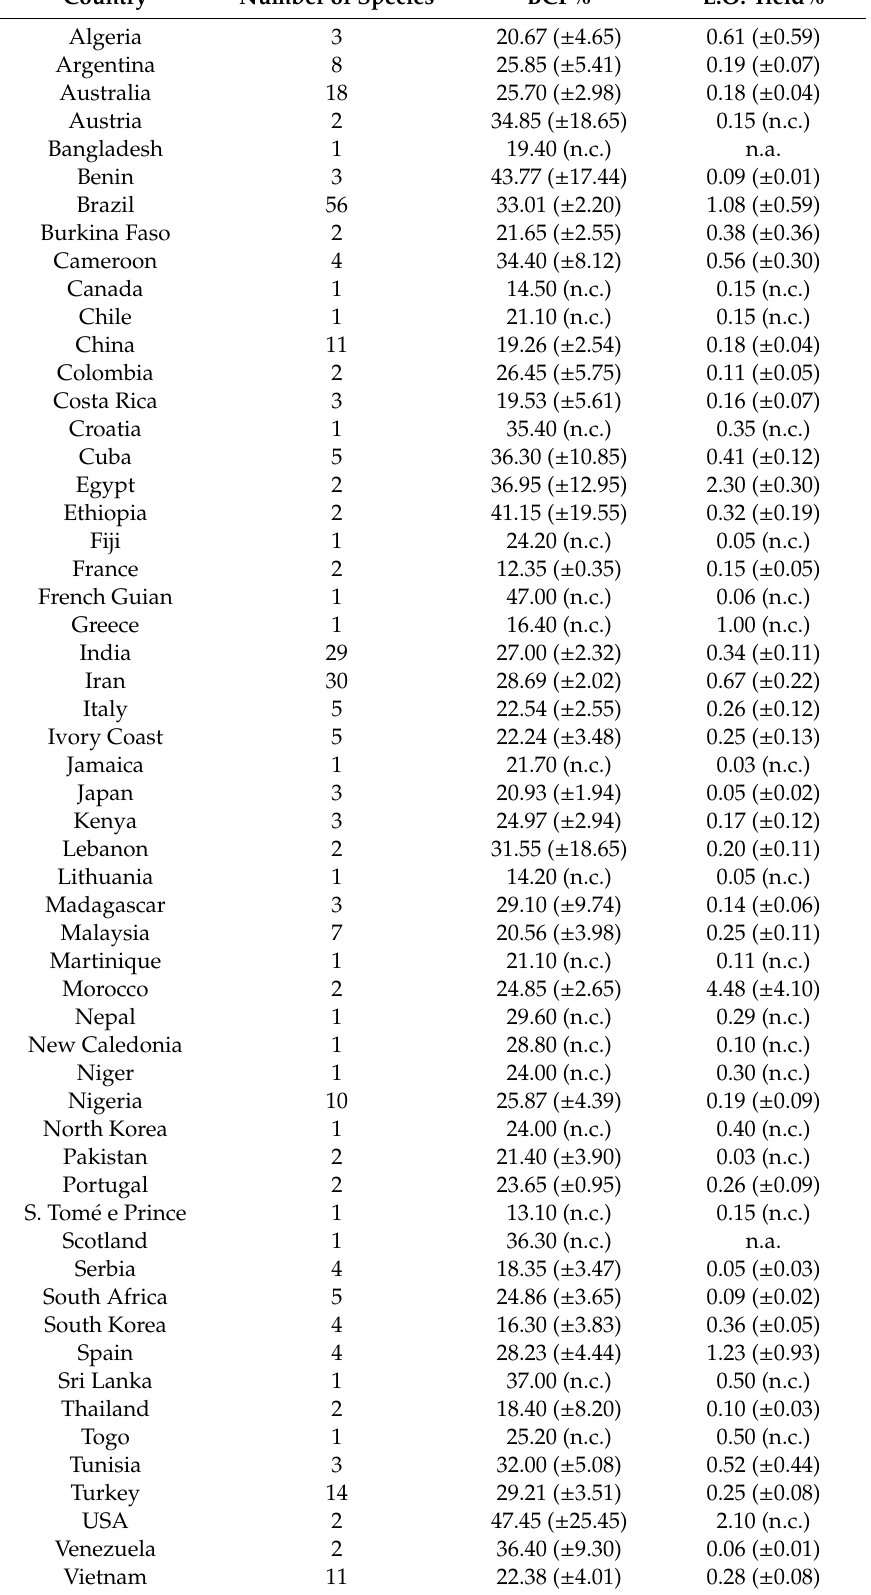
Table 5. Average percentages of BCP and yields from countries from which plant species reported in Table 1 were sampled. ( ± S.E.M.); n.c., not computable; n.a., not available; E.O., essential